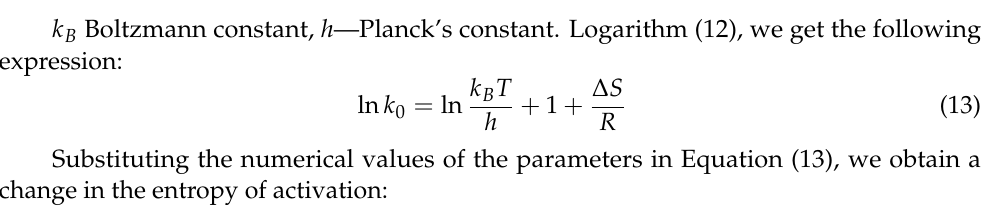
3747.8 + 7.0703 , R 2 = 0.9558 ). + 7.0703, R 2 = T 𝑇